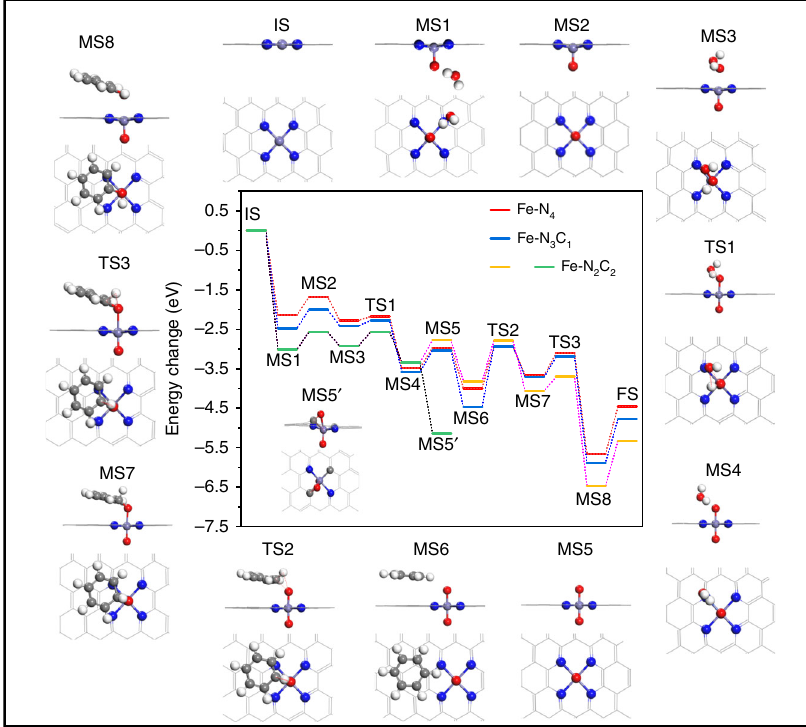
Fig. 5 DFT calculation. Energy diagram of benzene oxidation on Fe-N x C y SAs/N-C catalysts with the related reaction con fi gurations on Fe-N 4 surrounded (IS: initial catalyst, MS1: the fi rst H 2 O 2 cleavage adsorption, MS2: Fe = O con fi gurations, MS3: the second H 2 O 2 adsorption on the opposite side, TS1: transition state of the formation for the second H 2 O, MS4: the second H 2 O adsorbed con fi guration, MS5: O = Fe = O moiety, MS5 ′ : the abnormal O = Fe = O species on Fe-N 2 C 2 , MS6: adsorption of C 6 H 6 , TS2: transition state of C – O bond generation, MS7: C 6 H 6 O adsorption structure, TS3: transition state of H transfer from C to O, MS8: product bonded species, FS: regeneration of activity Fe = O center). The white, gray, red, blue and bluish violet balls refer to H, C, O, N, and Fe atoms,